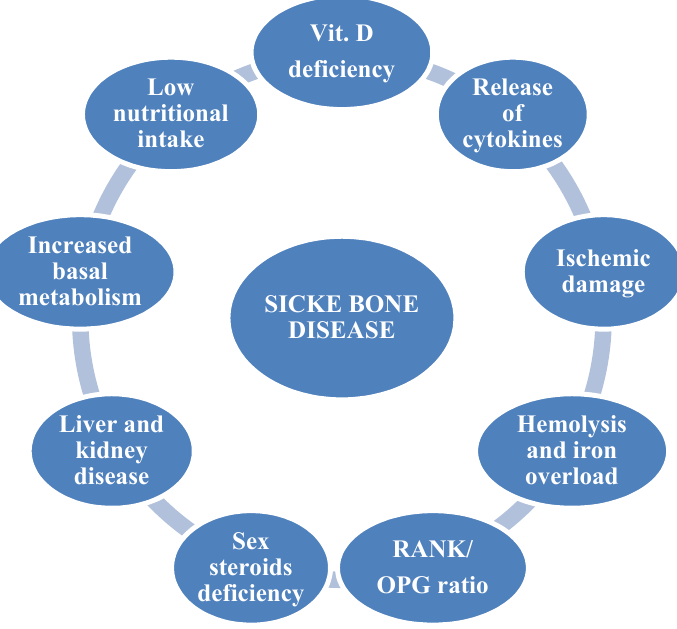
Figure 1. Pathogenetic factors of sickle bone disease.